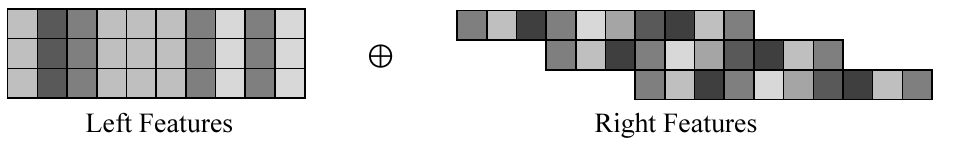
Figure 3. Our sparse cost volume ( S = 3 ) . We propose a parameter S for stride size to control the